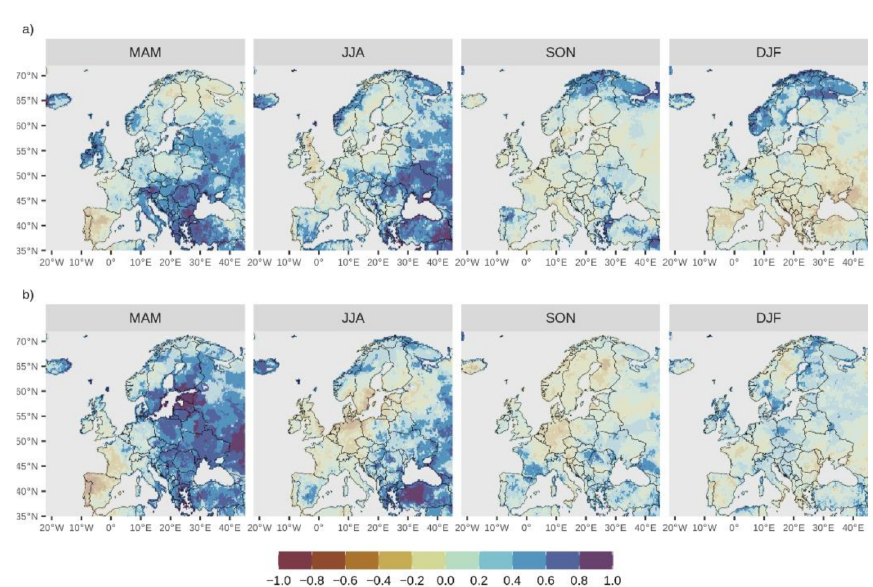
Figure 3. Spatial distribution of ROCSS for ( a ) first and ( b ) third tercile for unadjusted ECMWF SEAS5 ensemble seasonal forecasts of 2-m mean air temperature (one-month lead time) over Europe (land only) with respect to the climatological forecast over 1993–2016. Unshaded colors indicate grid cells with significant positive scores.